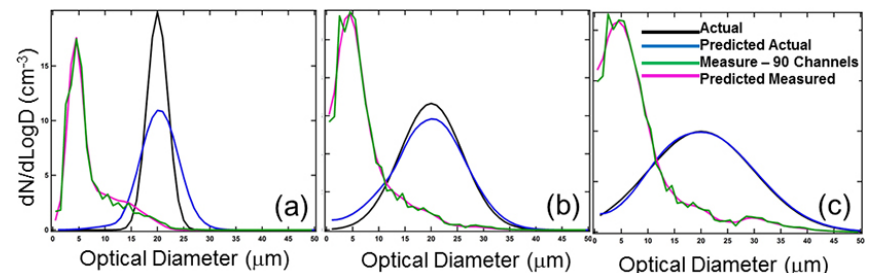
Figure 8. The three panels illustrate how the accuracy of retrieving the actual size distribution is related to the width of the distribution. The black curve is a simulated distribution with an average diameter of 20µm and standard deviation of 2µm, 6µm and 10µm in panels (a) , (b) and (c) respectively. The blue curves are the distributions retrieved from the simulated measurements shown in green and the red curve shows the predicted measurement after the inversion.